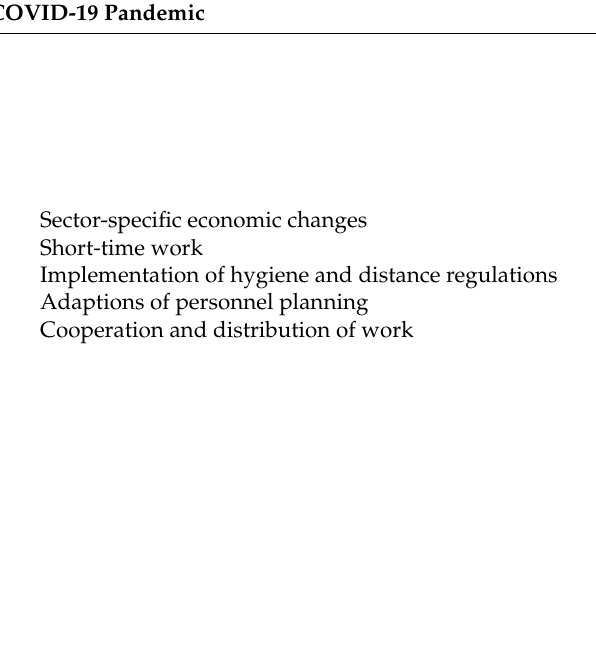
Table 3. Overview of the work-related changes and impacts of the COVID-19 pandemic in social firms. Work-Related Changes in Social Firms during the COVID-19